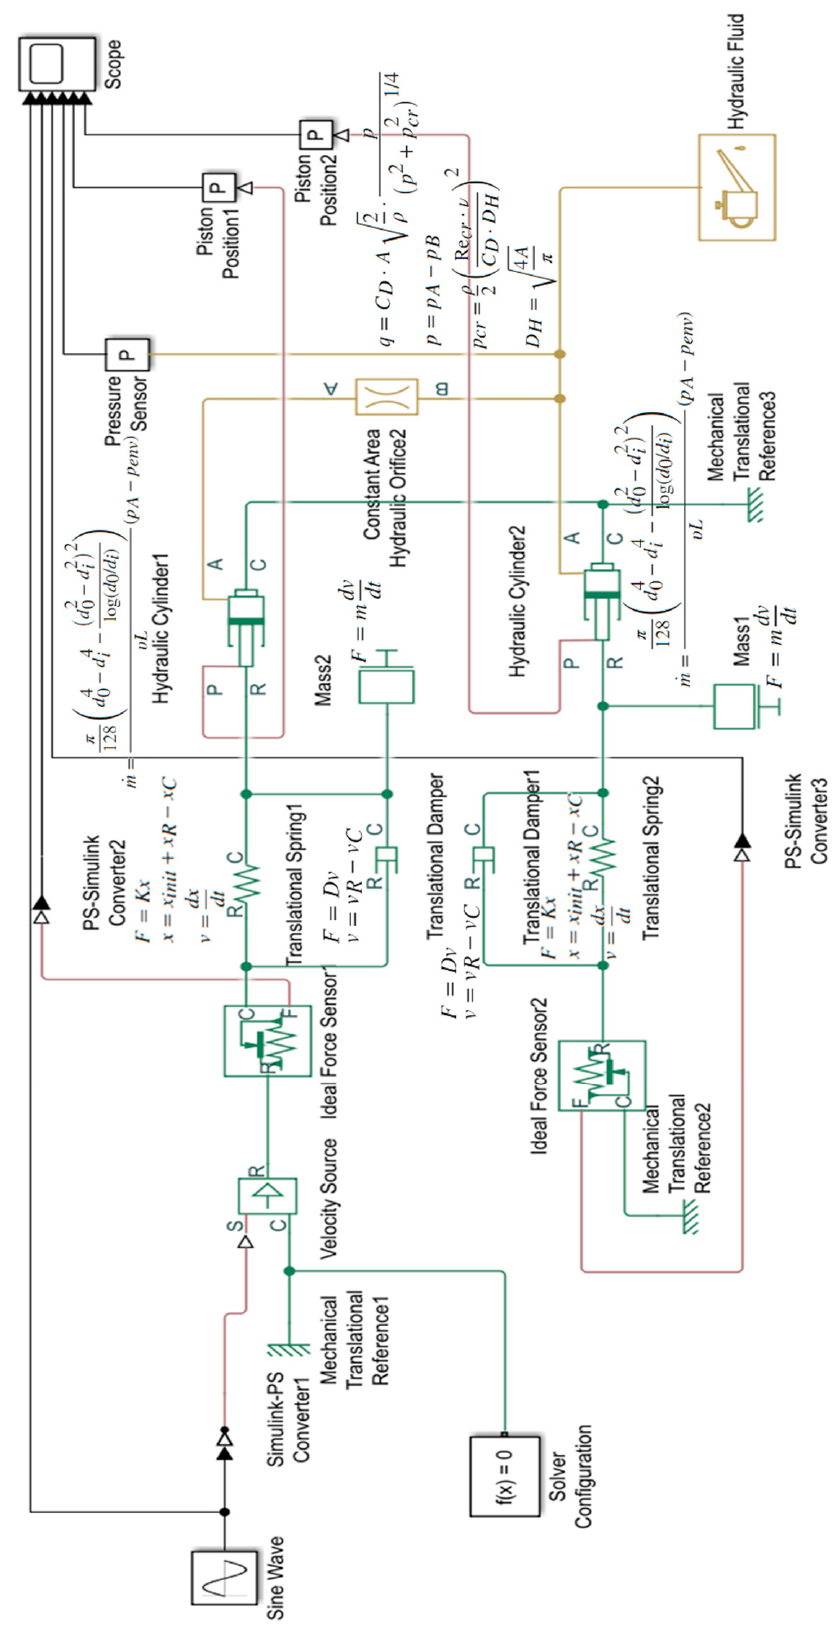
Figure 2. Simscape model for the kinematic analysis of NABE-RE.